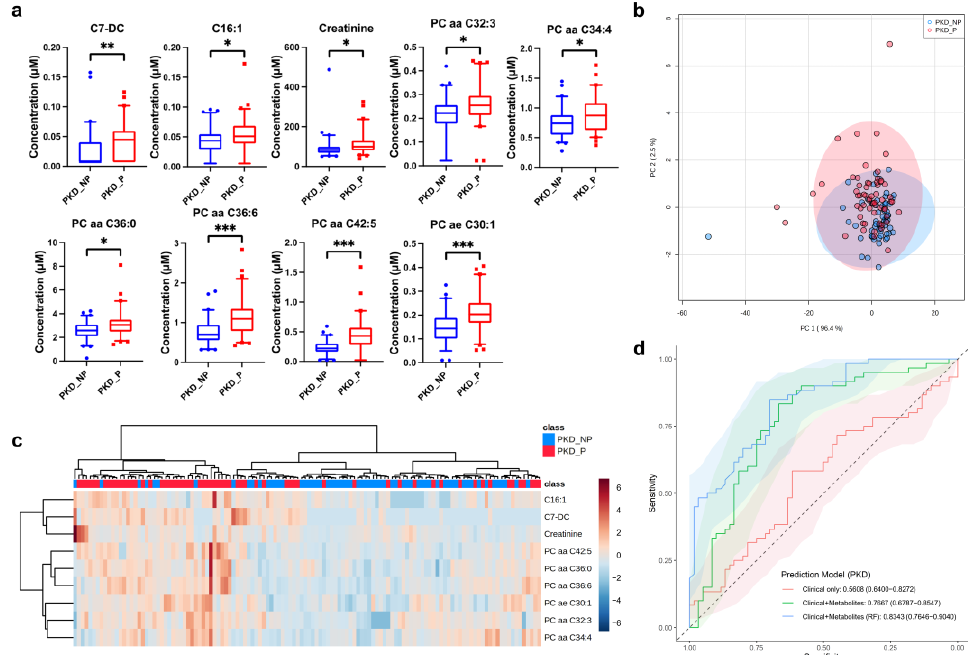
Figure 4. Multivariate statistical analysis and predictive modeling of the selected PKD progression-related biomarkers. ( a ) Individual box-and-whisker plot (median, 5–95 percentile) of the selected metabolites in PKD progressors (P, red) and non-progressors (NP, blue). ( b ) PCA of two components of selected metabolites from PKD progressors (P, red) and non-progressors (NP, blue). ( c ) Heatmap and hierarchical clustering analysis of the selected metabolites from PKD progressors (P, red) and non-progressors (NP, blue). ( d ) ROC curves for three prediction models of PKD progression: models using clinical parameters only (red) or together with selected metabolite biomarkers (green: by logistic regression; blue: by random forest). Solid line: mean AUC of the 5-fold cross-validation. Shaded area: 95% CI of AUC. * q < 0.05, ** q < 0.01, *** q < 0.001. PC aa: diacyl-phosphatidylcholine; PC ae: